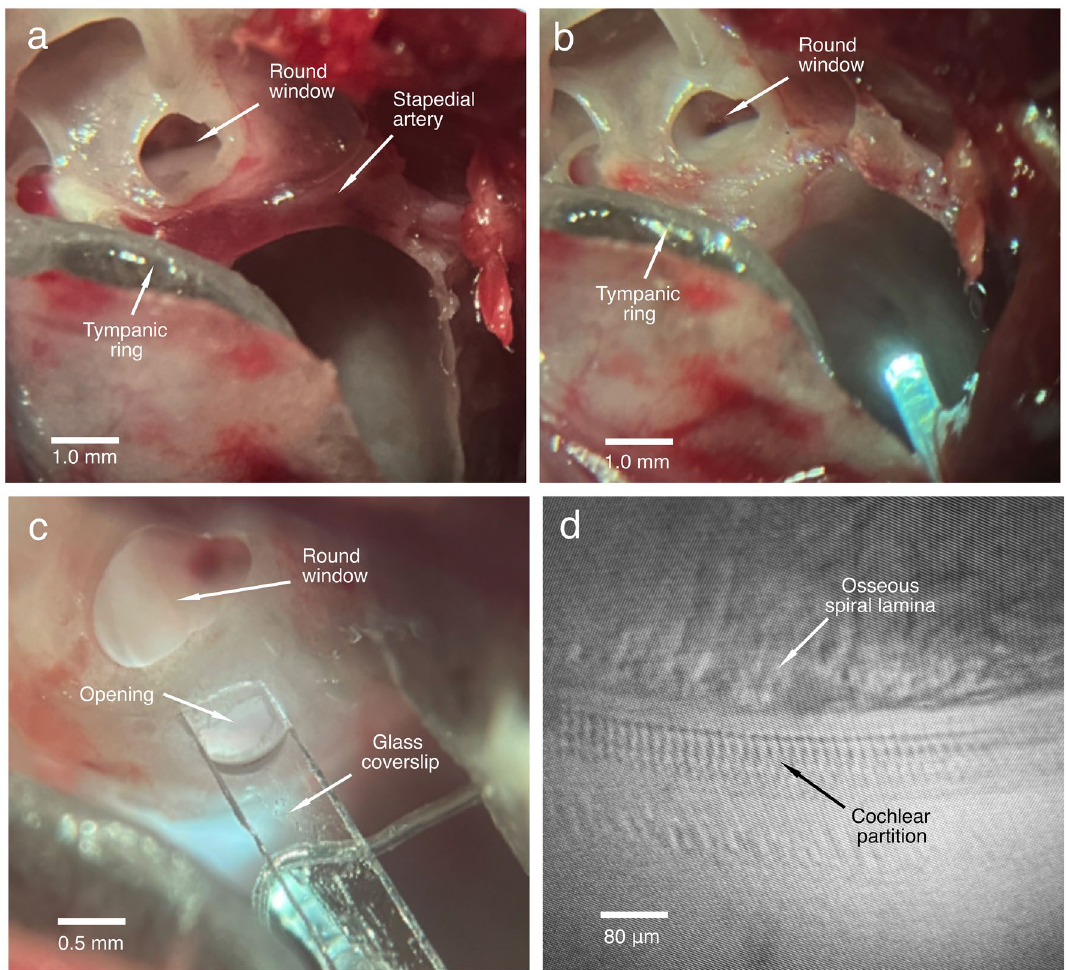
Figure 5. Images of the surgical field and the cochlear partition. ( a ), The stapedial artery blocks the optical access to the cochlear partition in the transverse direction. ( b ), The stapedial artery and surrounding bony structure have been removed from the basal turn. ( c ), An opening was made in the bony lateral wall of the scala tympani to visualize the cochlear partition. ( d ), Micrograph of the osseous spiral lamina and the cochlear partition in a sensitive cochlea. Images ( a – c ) were taken through a surgical microscope and ( d ) was a screen snapshot through a custom microscope using an objective lens (Plan Apo 20X, NA 0.28, Mitutoyo, non-perpendicular optical axis. When the optical axis is not in the transverse direction of the cochlear partition, the object beam accesses the RL and BM at different longitudinal locations (indicated by locations A and C in Fig. 1b). The longitudinal location difference can result in a phase difference between the RL and BM vibration 27 . This is a legitimate concern because the optical axis might not be precisely in the transverse direction despite a great effort to optimize the access angle of the object beam in the recent experiments 23,28,43 . The objective of the present study was to determine whether the observed phase difference between the RL and BM vibration is a measurement error by measuring cochlear partition vibration in the transverse direc- tion through an opening in the lateral wall of the scala tympani. Compared with the round window approach, the shorter distance between the lateral wall opening and the cochlear partition allows the object beam of the interferometer to access the partition approximately in the transverse direction. This is indicated by the image of the cochlear partition at the measured longitudinal location (Fig. 5d). If the phase difference results from the measurement error due to the extra delay from the longitudinal location B to C caused by the non-perpendicular optical axis (Fig. 1b), the group delay difference between the RL and BM vibration should become smaller when it is measured in the transverse direction. However, the present data show that the group delay difference between the RL and BM vibration measured in the transverse direction through the LWO is significantly larger than that measured with a non-perpendicular optical axis through the RW 24,26,42 (Fig. 4b). This result does not support the hypothesis that the non-perpendicular optical axis causes the group delay difference between the RL and BM vibration. The larger group delay difference measured in this study likely results from changes in the spatial relationship between the object beam and the microstructures of the cochlear partition. This interpretation, however, remains to be confirmed by measuring the three-dimensional vibration 44 from different locations of the microstructures within the cochlear partition. Moreover, the predicted measurement error-induced phase